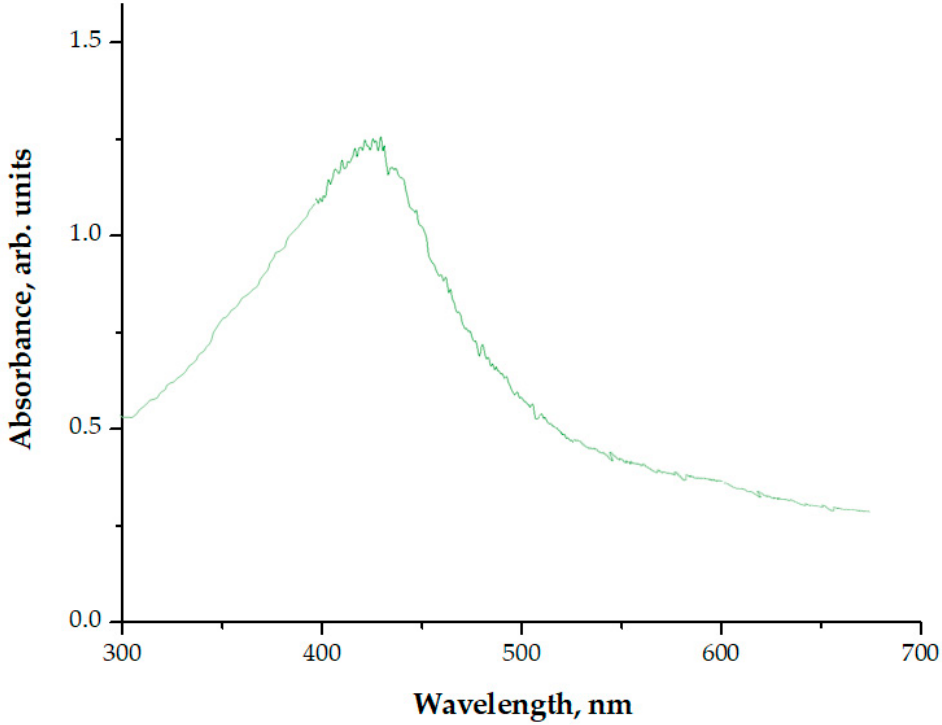
Figure 3. UV-Vis spectrum of the suspension obtained after the synthesis of Fe 3 O 4 @Ag particles using the 3% arabic gum